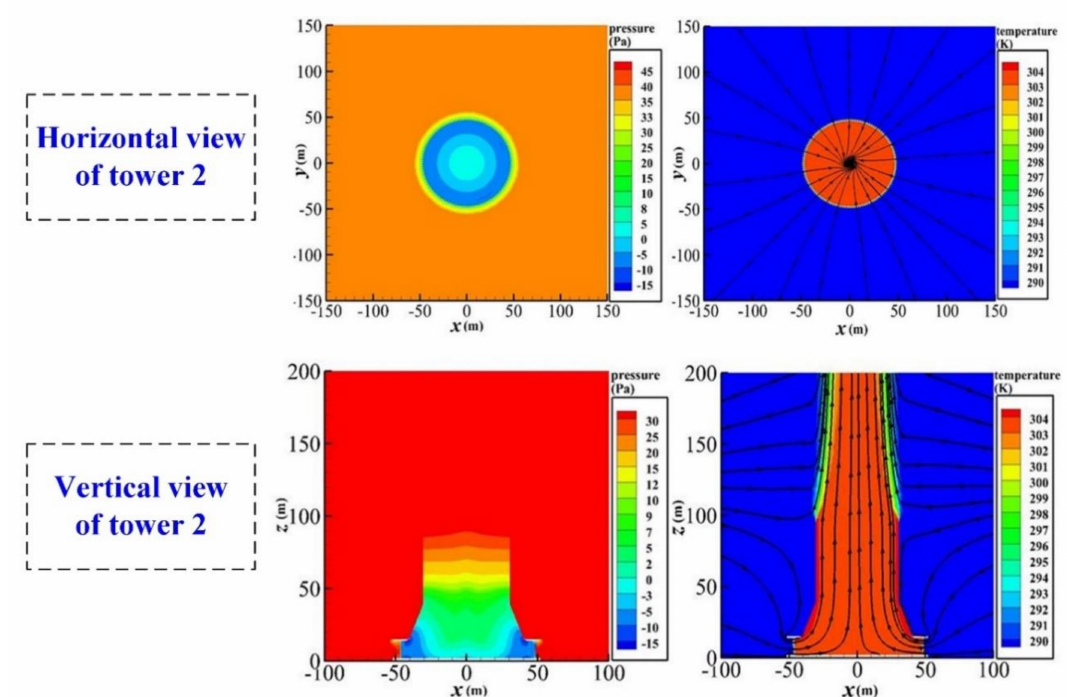
Figure 7. Air variable contours for steel-truss NDDCS with conical/cylindrical tower configuration without ambient wind.